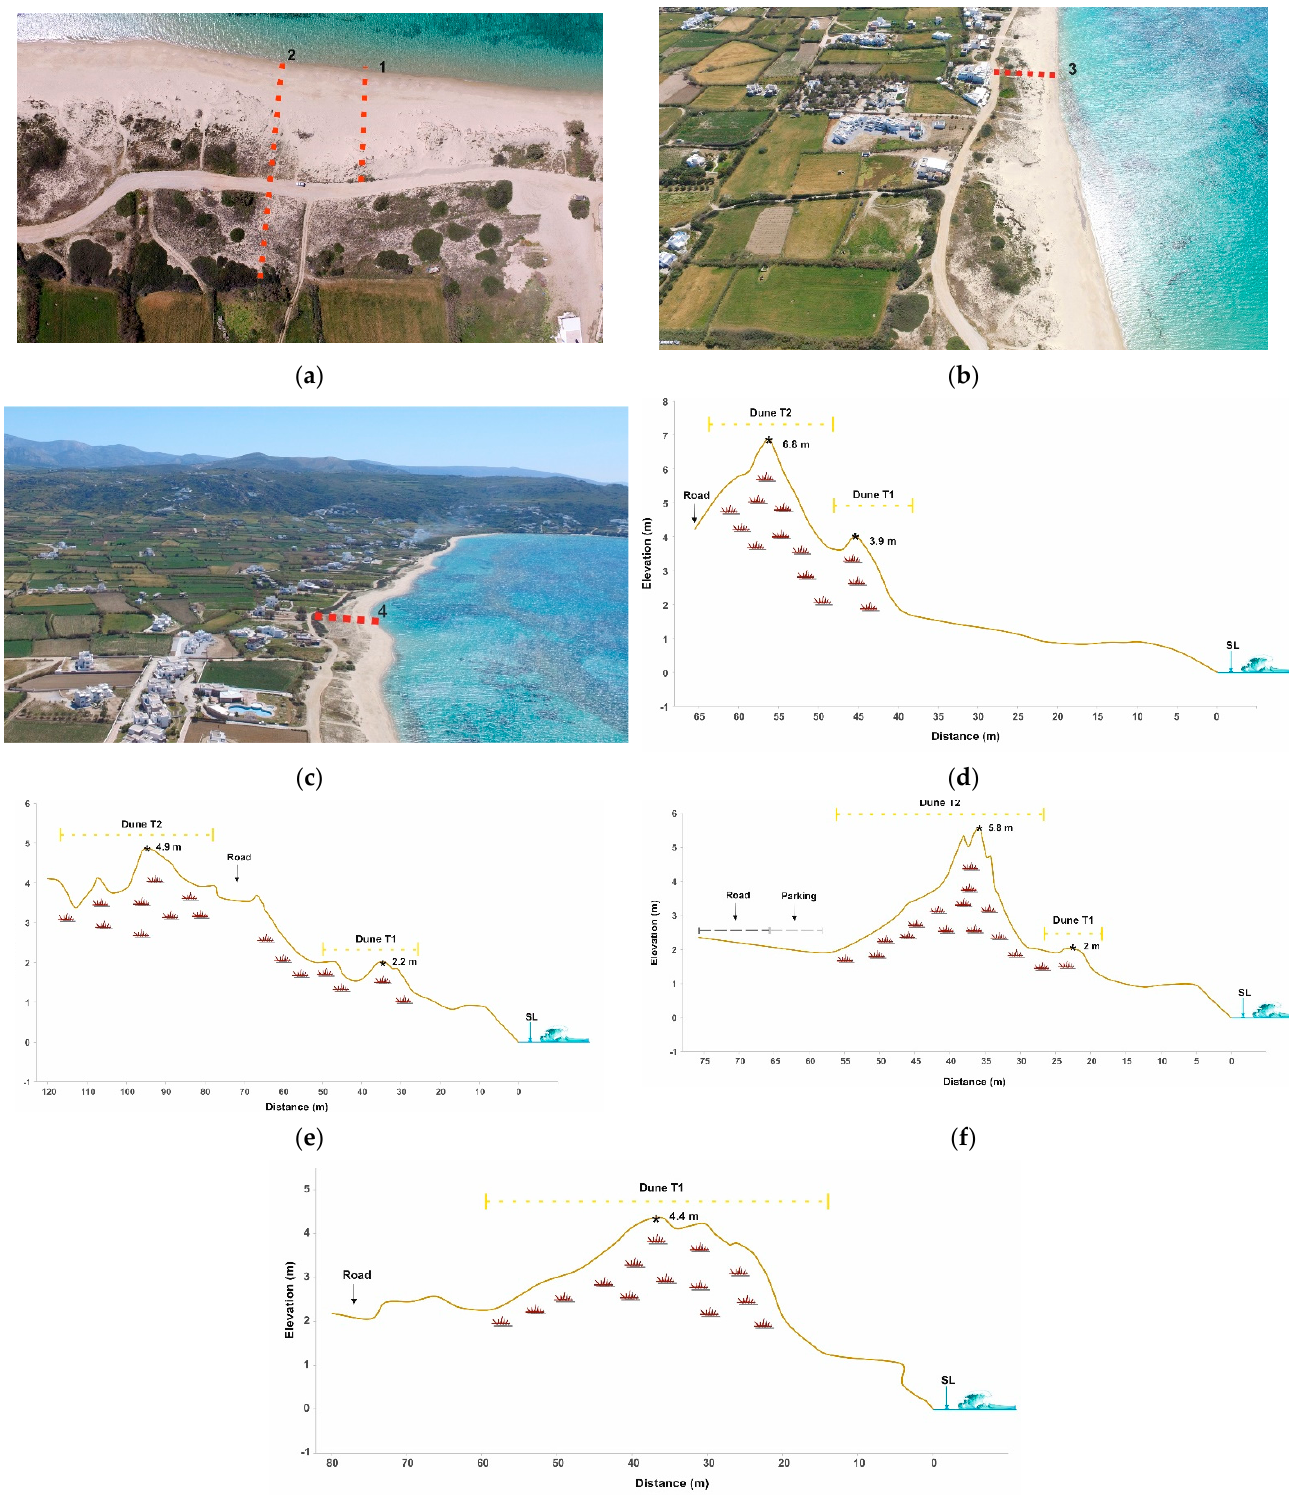
four cross sections: Plaka 1 (Figure 6a,d), Plaka 2 (Figure 6a,e), Plaka 3 (Figure 6b,f), and Plaka 4 (Figure 6c,g).